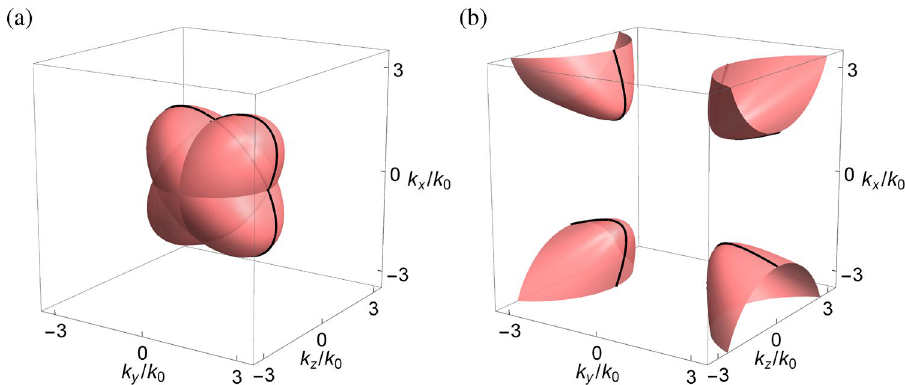
Figure 1. Equifrequency surfaces of bulk modes in the wave vector space for the pseudochiral metamaterial with ( a ) ε n = µ n = 2 and γ = ± 1 ( b ) ε n = µ n = 1.5 and γ = ± 2 ( n = t , z ). Black contours are bulk modes at k z = 0 (cf. Fig. 2).